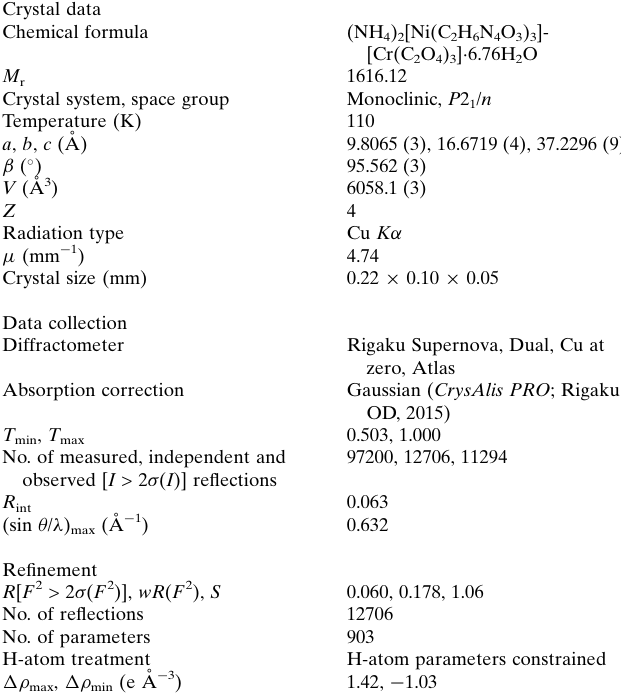
Table 3 Experimental details. Crystal data Chemical